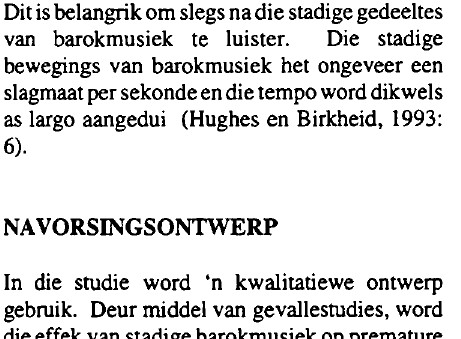
Figuur 1: Gemiddelde harttempo van die babas voor hantering